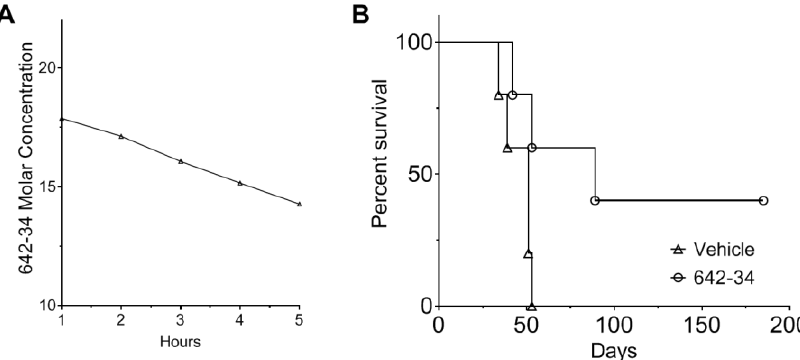
Figure 6. Stability of CCF642-34 and restriction of multiple myeloma in a syngeneic mouse model by PDIA1-inhibitor CCF642-34. ( A ) The stability of CCF642-34 was measured against oxidative metabolism by human liver microsomes. CCF642-34 (20 µ M) was incubated with 0.25 mg/mL of human liver microsomes for 5 h. The residual compound at indicated time points was measured by HPLC (Agilent 1260 Infinity II) interfaced with reverse phase C18 column using 280 nm and 245 nm detection wavelength. The standard curve of known concentrations of CCF642-34 was obtained from the area under the peak at two wavelengths, and the remaining CCF642-34 was estimated. Data are representative of two independent experiments. ( B ) 5TGM1-luc/C57BL/KaLwRij mouse models of myeloma (3 males, 3 females per treatment group) were engrafted with 2 × 10 6 5TGM1-luc cells via tail vein injection and treated 3 times a week for 8 weeks per oral gavage with 20 mg/kg of CCF642- 34 dissolved in 10% 2-hydroxy-propyl- β -cyclodextrin. The survival of each group was monitored, and Kaplan–Meier survival analysis was performed. All control animals required euthanasia before 52 days (due to paraparesis, weight loss, poor general condition), while 3 out of 6 mice treated with CCF642-34 lived beyond 6 months with no sign of